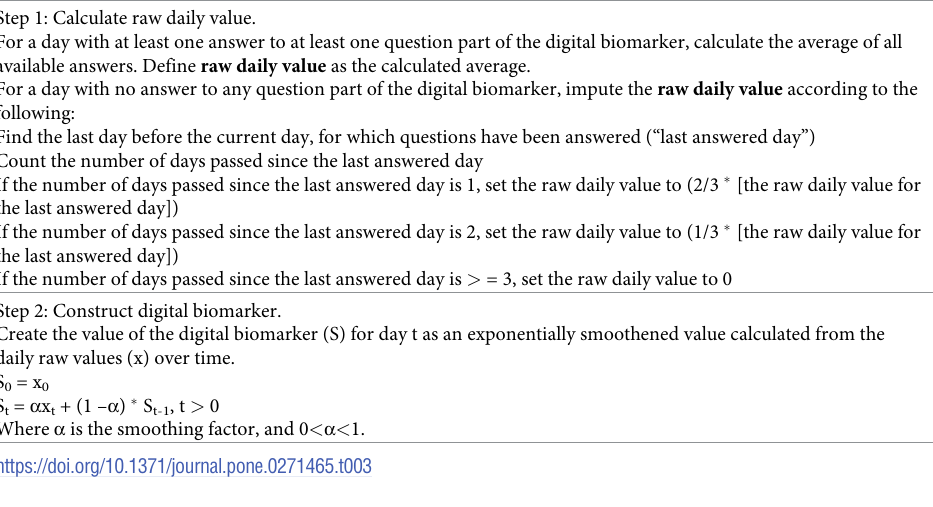
Table 3. Generic algorithm for constructing a questionnaire based digital